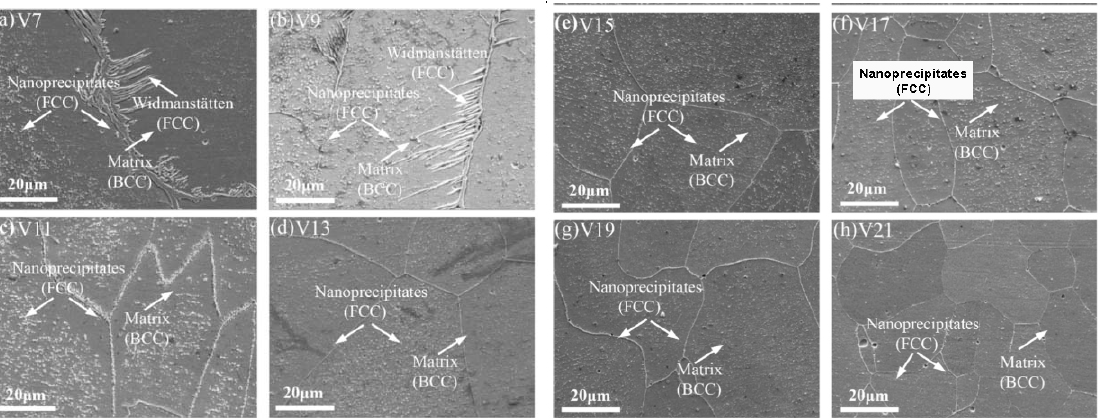
Figure 9. SEM micrographs of Al 16.80 Co 20.74 Cr 20.49 Fe 21.28 Ni 20.70 HEA coatings deposited with different laser scanning speeds: ( a , b ) are the coatings named as V7 and V9. They contain Widmanstätten side plate and nanoprecipitates; ( c – h ) the coatings named as V11–V21 contain only nanoprecipi- tates, without Widmanstätten plate. Reprinted with permission from Ref. [70]. Copyright 2021 Elsevier.